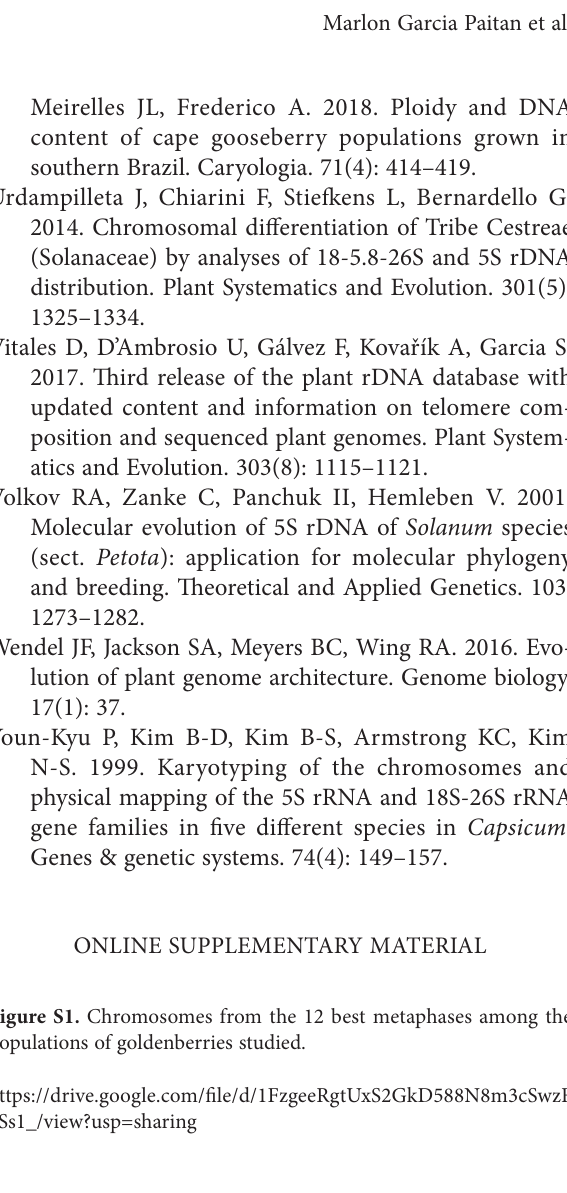
Figure S1. Chromosomes from the 12 best metaphases among the populations of goldenberries